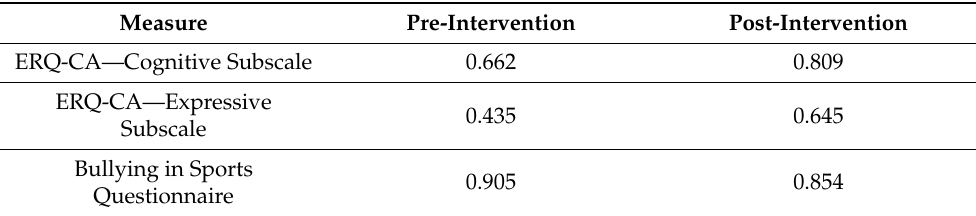
Table 2. Cronbach Alpha reliability coefficients for both measures in their two applications. Measure Pre-Intervention Post-Intervention ERQ-CA—Cognitive Subscale 0.662 0.809 ERQ-CA—Expressive 0.435 0.645 Subscale Bullying in Sports 0.905 Questionnaire